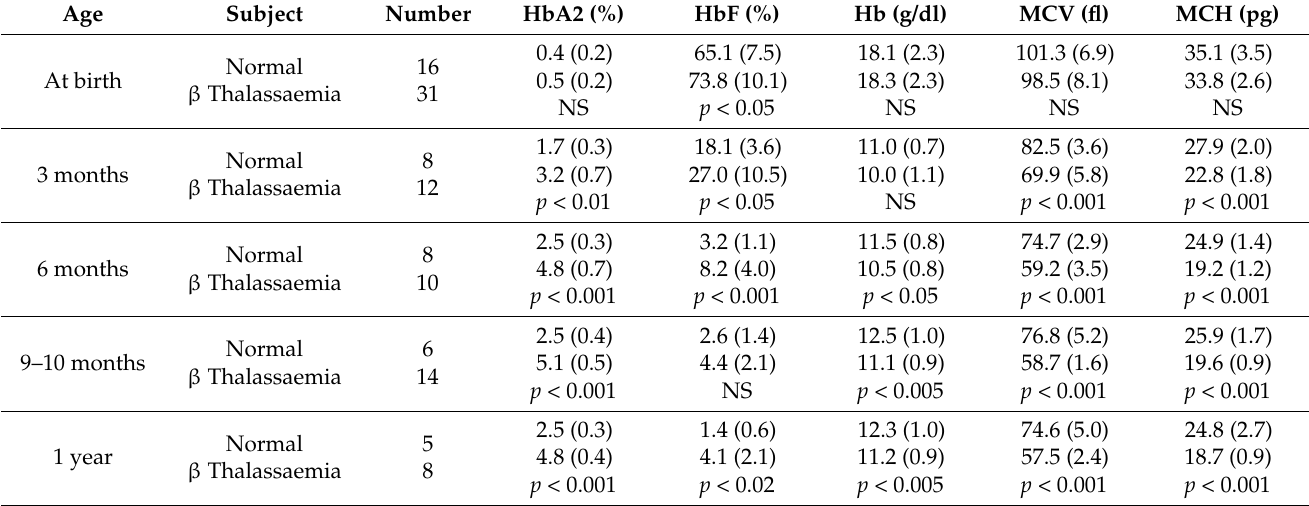
Table 8. Values of HbA2, HbF and some relevant erythrocyte indices in normal infants and in beta thalassemia carriers during the first year of life.